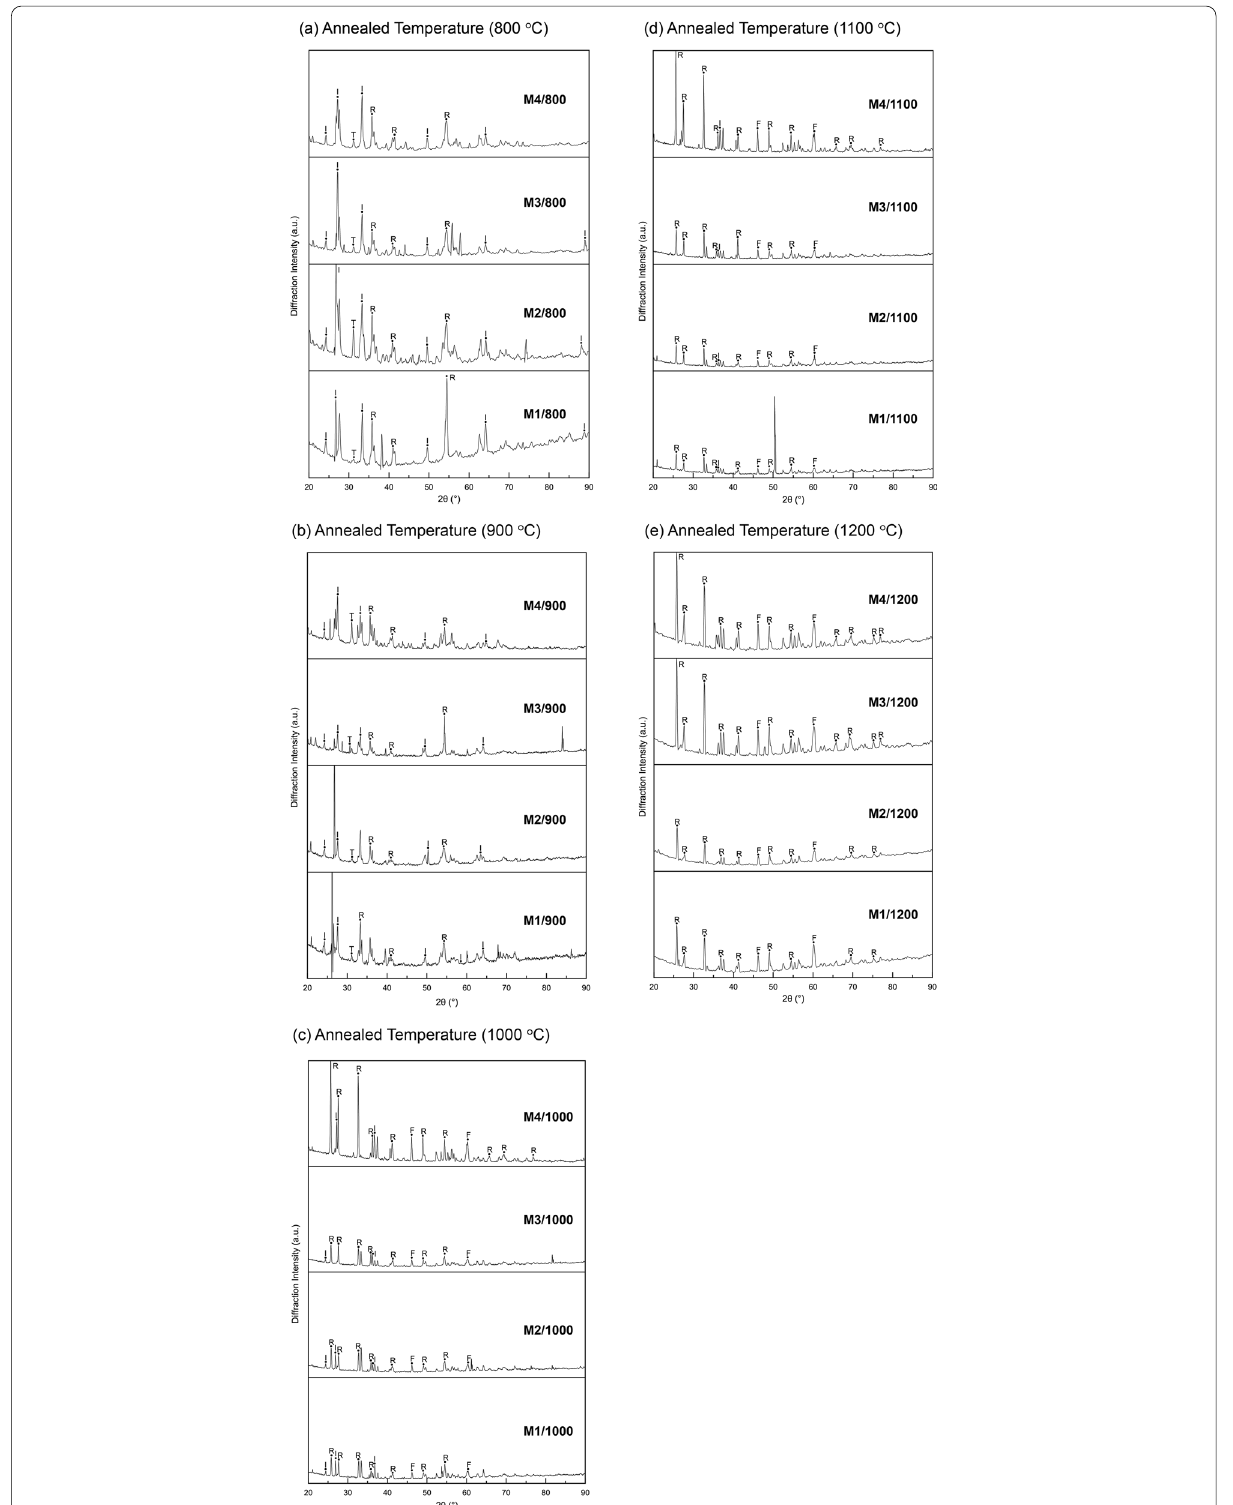
Fig. 4 X-ray diffraction patterns of ilmenite samples ( a ) annealed at 800 °C, ( b ) annealed at 900 °C, ( c ) annealed at 1000 °C, ( d ) annealed at 1100 °C, and ( e ) annealed at 1200 °C. Where, I: ilmenite (FeTiO 3 ), R: rutile (TiO 2 ), F: elemental iron. (see Table 1 for sample